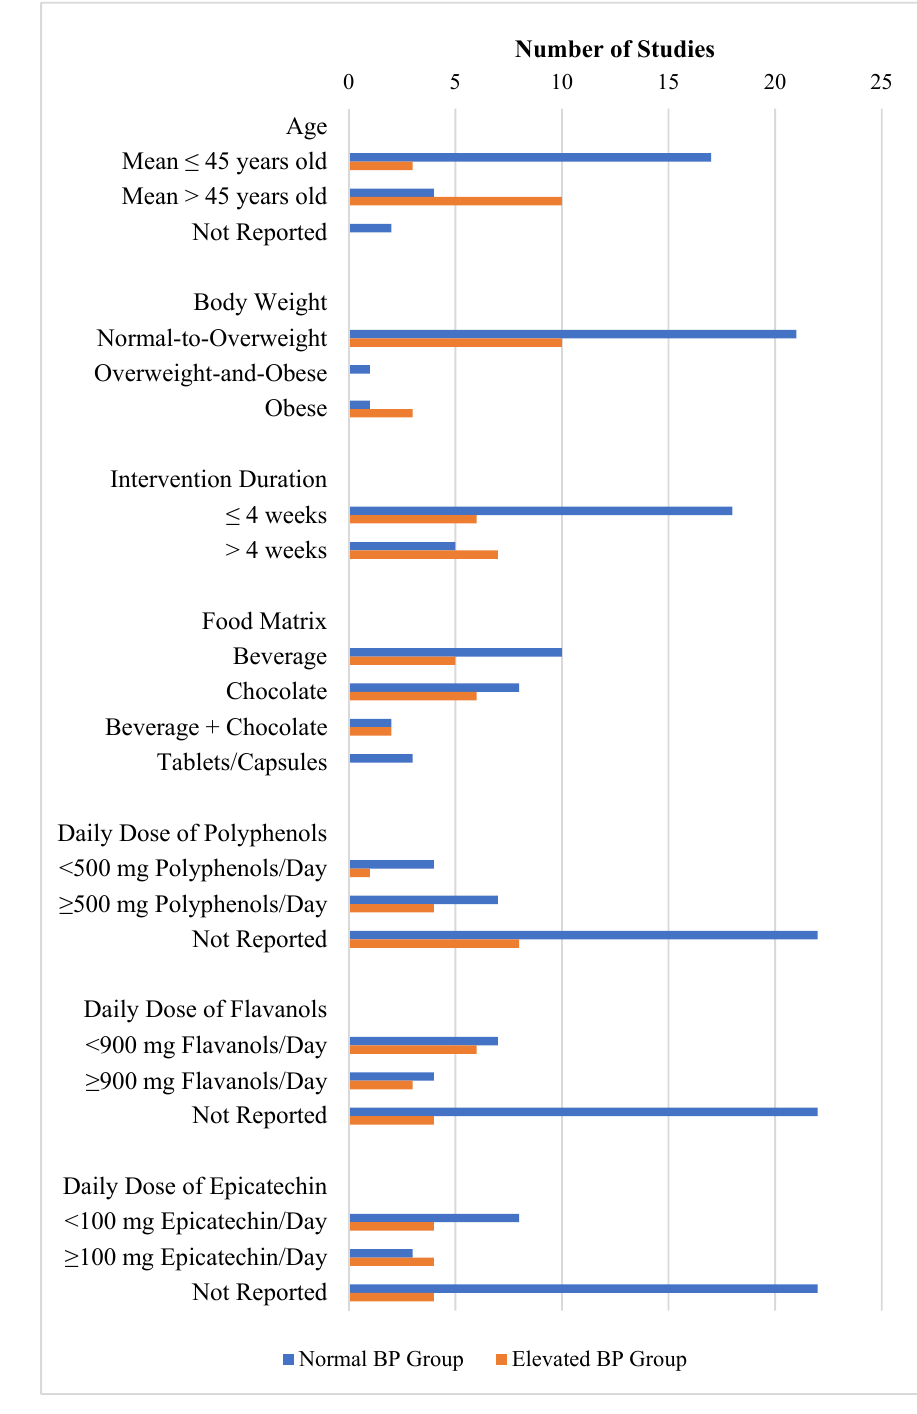
Figure 2. Summary of study characteristics grouped by pre-intervention BP.